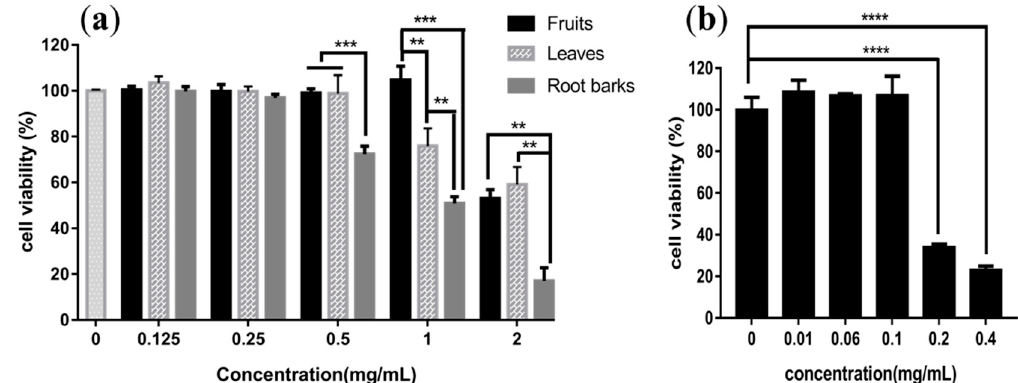
Figure 5. The cytotoxicities of different concentrations of extracts from fruits, leaves, root barks ( a ) and kukoamine B ( b ) towards L02 cells. Results were expressed as means ± S.D., n = 3. ** p < 0.01, *** p < 0.001, **** p < 0.0001.